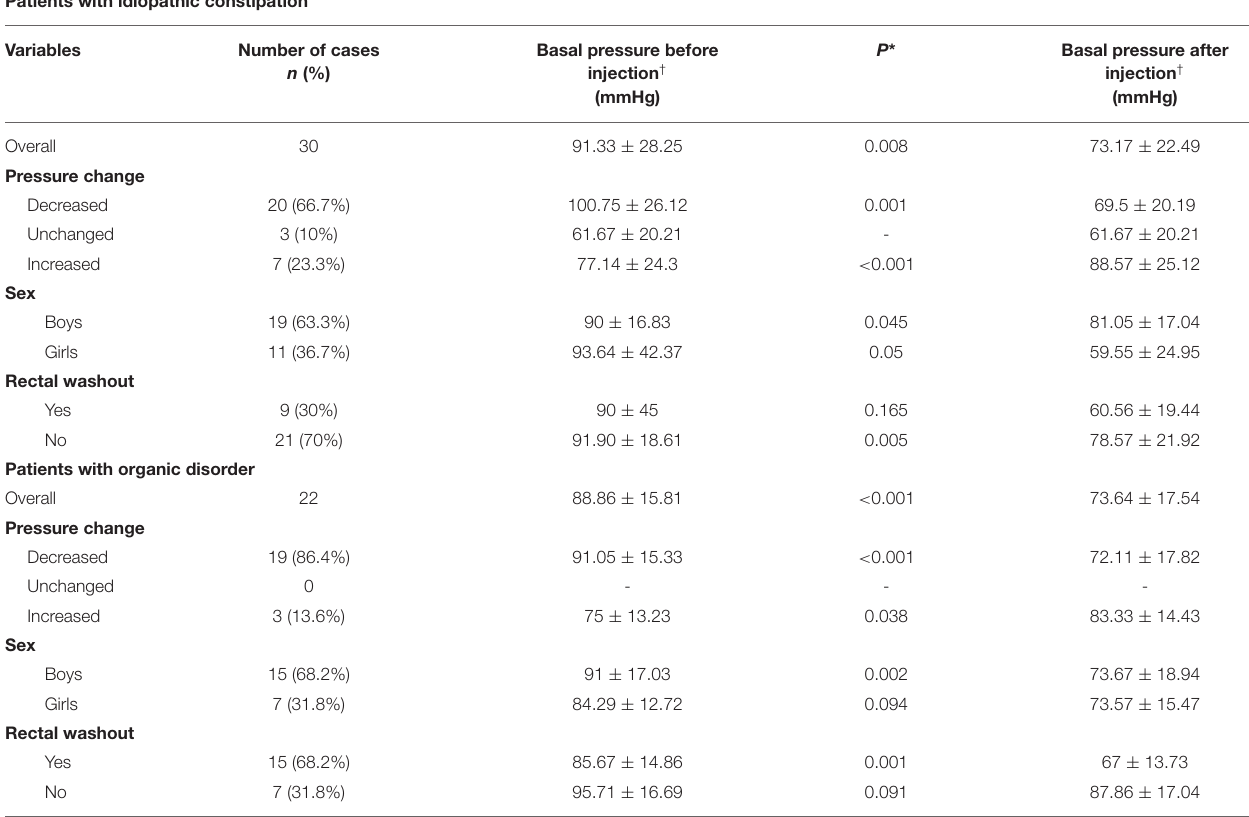
TABLE 2 | Anal basal pressure before and after botulinum toxin injection. Patients with idiopathic